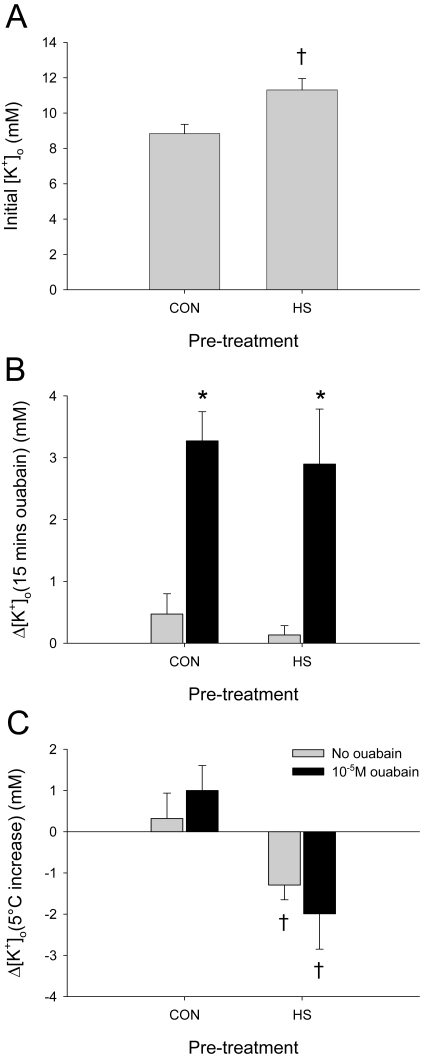
HS and ouabain affect [K+]o.A. Heat shock preconditioning resulted in a significantly higher [K+]o in HS locusts compared to CON locusts. All animals pooled: NCON = 25; NHS = 26. B. CON-OUA and HS-OUA locusts had a significantly greater increase in [K+]o after 15 minutes of bath application with 10−5 M ouabain compared to CON and HS locusts. HS pre-treatment did not have an effect on Δ[K+]o over this 15 minute period (NCON = 12; NCON-OUA = 10; NHS = 17; NHS-OUA = 8). C. CON and HS locusts had a markedly different Δ[K+]o in response to a 5°C increase in temperature. Δ[K+]o was positive in CON locusts and negative in HS locusts after only one minute of temperature increase. There was no effect of 10−5 M ouabain treatment on Δ[K+]o one minute into the temperature ramp (NCON = 12; NCON-OUA = 10; NHS = 17; NHS-OUA = 8). Asterisks indicate a significant effect of ouabain and daggers indicate a significant effect of pre-treatment according to t-test (A) and post hoc Tukey tests (P<0.05) (B,C).